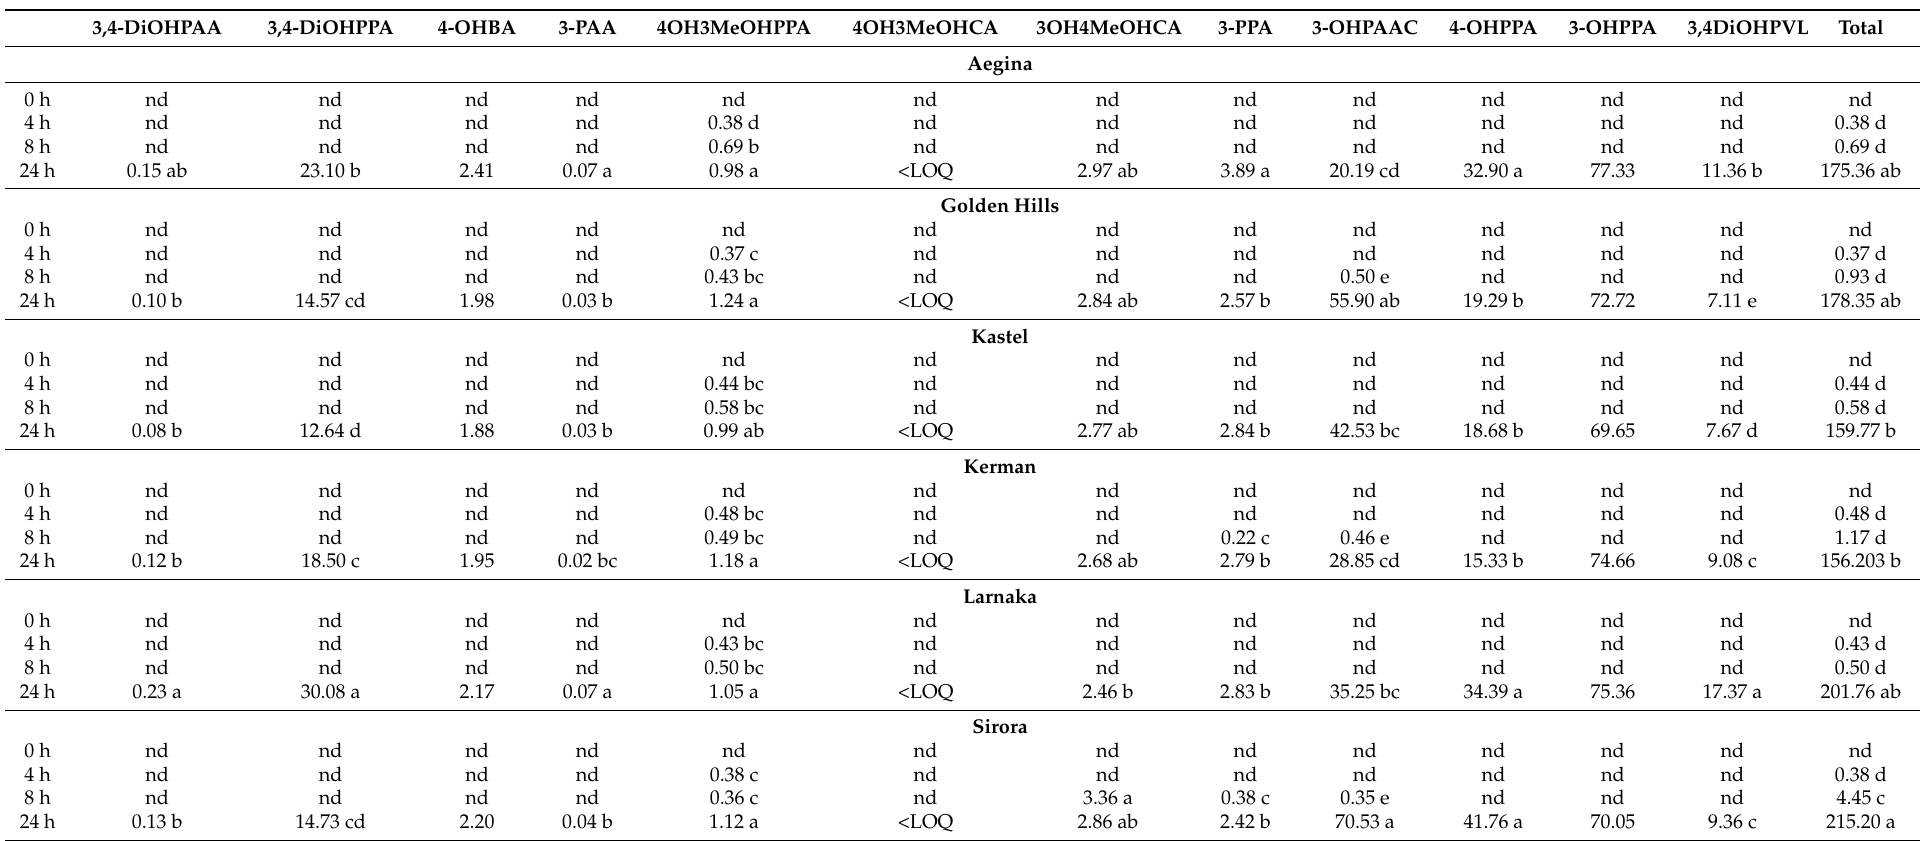
Table 4. Catabolites produced during in vitro colonic fermentation in pistachios